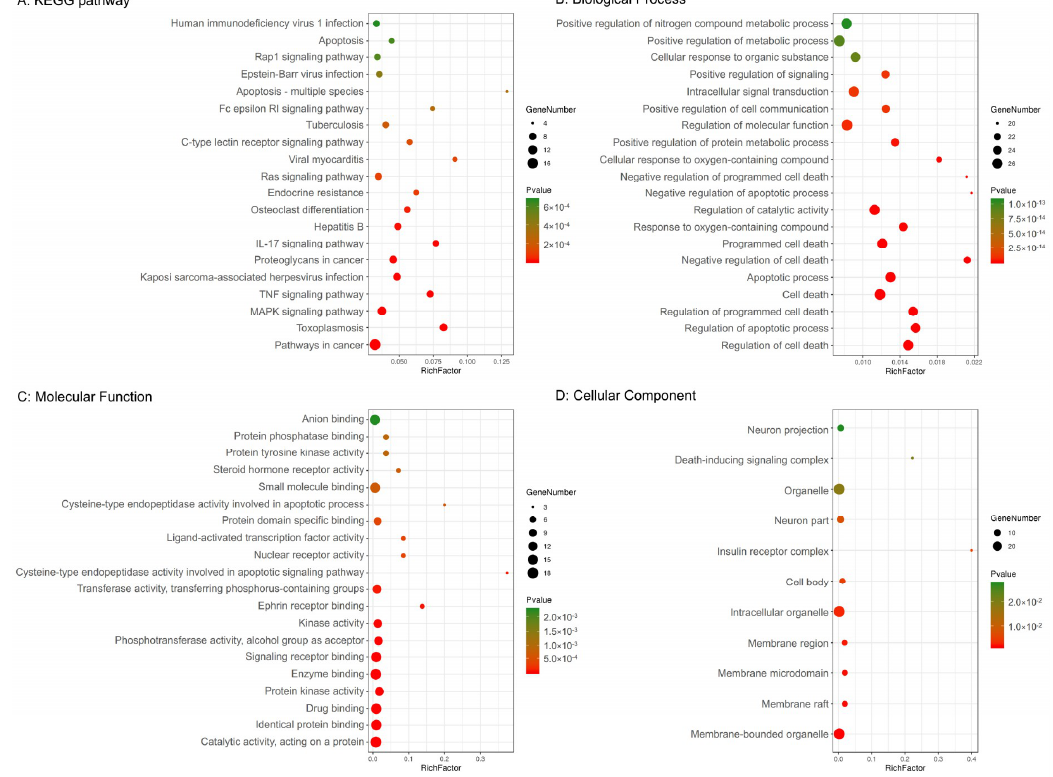
Figure 2. Kyoto Encyclopedia of Genes and Genomes (KEGG) pathway and gene ontology enrichment analyses of 29 target proteins ( p -value ≤ 0.05). ( A ) The top 20 KEGG pathways. ( B ) The top 20 biological processes. ( C ) The top 20 molecular functions. ( D ) Eleven cellular components. The color scales indicate the di ff erent thresholds for the p -values, and the sizes of the dots represent the number of genes corresponding to each